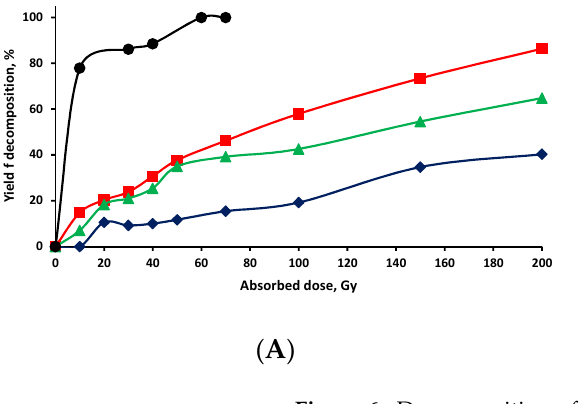
Figure 2. Efficiency of sertraline degradation and ionic products formation in aqueous solution saturated before irradiation with N 2 O- • OH radicals predominate: ( ● )-sertraline 1 mg/L degradation, ( ■ )-Cl − formation, (  )-NO 3 − formation, ( ♦ )-NO 2 − formation.